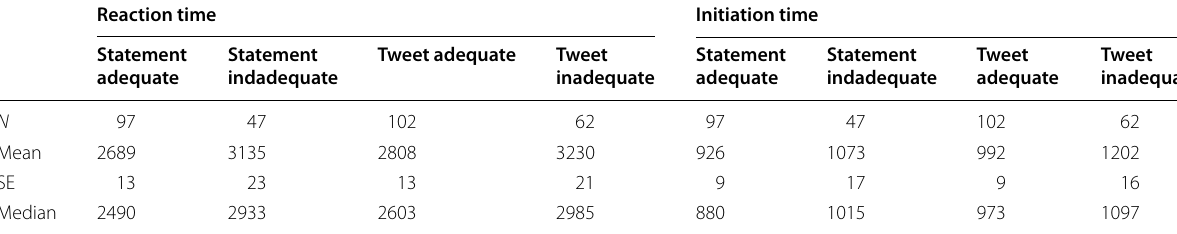
Table 2 Descriptive statistics—reaction time measurements for Experiments 1 and 2 Reaction